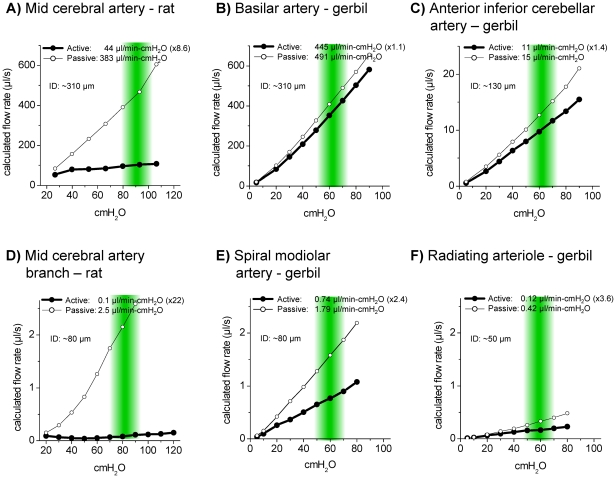
Calculated flow rate for brain arteries from rat and gerbil and cochlea arteries from gerbil.Male rat mid-cerebral artery (A) taken from Geary et al 1998 [19], male gerbil basilar artery (B) male gerbil anterior inferior cerebellar artery (C), female rat mid-cerebral artery territory branch (D), male gerbil spiral modiolar artery (E), male gerbil radiating arteriole (F). Green bars represent estimated physiological pressure range for each vessel according to which active and passive slope were calculated. Slope is given in µl/min –cmH2O. For active slope diameter was obtained in 10 µM L-NNA, for passive slope diameter was obtained in Ca2+-free solution.